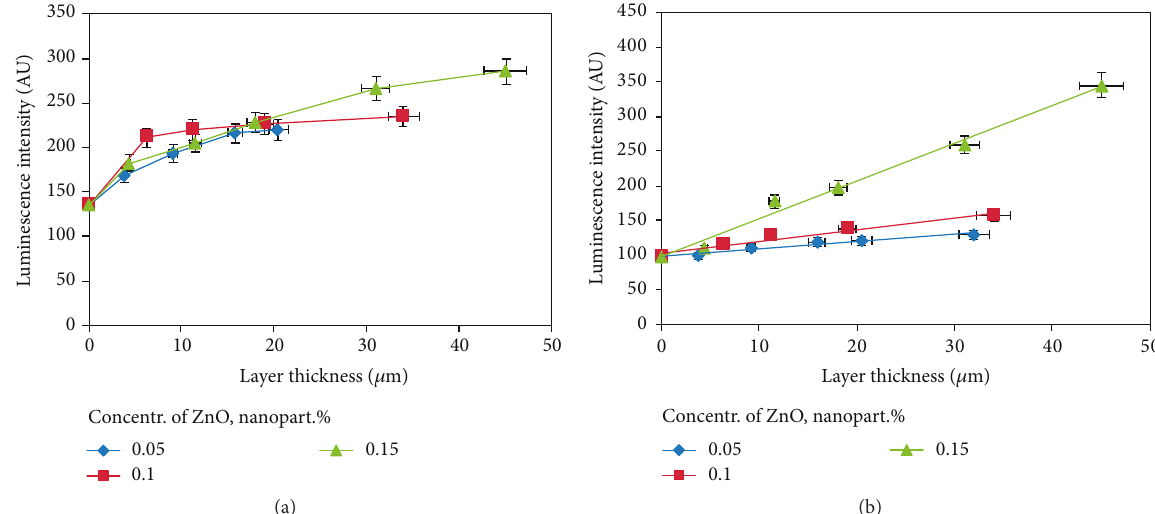
Figure 6: The dependency of the luminescence peak at 𝜆 = 430 (a) and 520 nm (b) of printed impressions on paper with the minimum content of OBAs (paper 1), obtained using ink compositions with different contents of the fluorescent component (ZnO nanoparticles), on ink layer thickness.